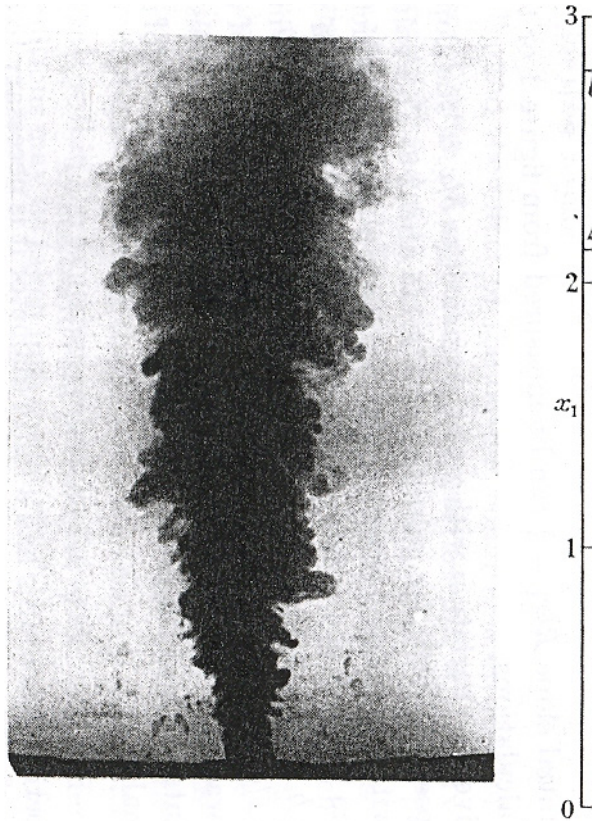
Figure 3. The entraining plume generated by an original water-tank experiment by Morton et al. (1956) (reproduced from Morton et al.,